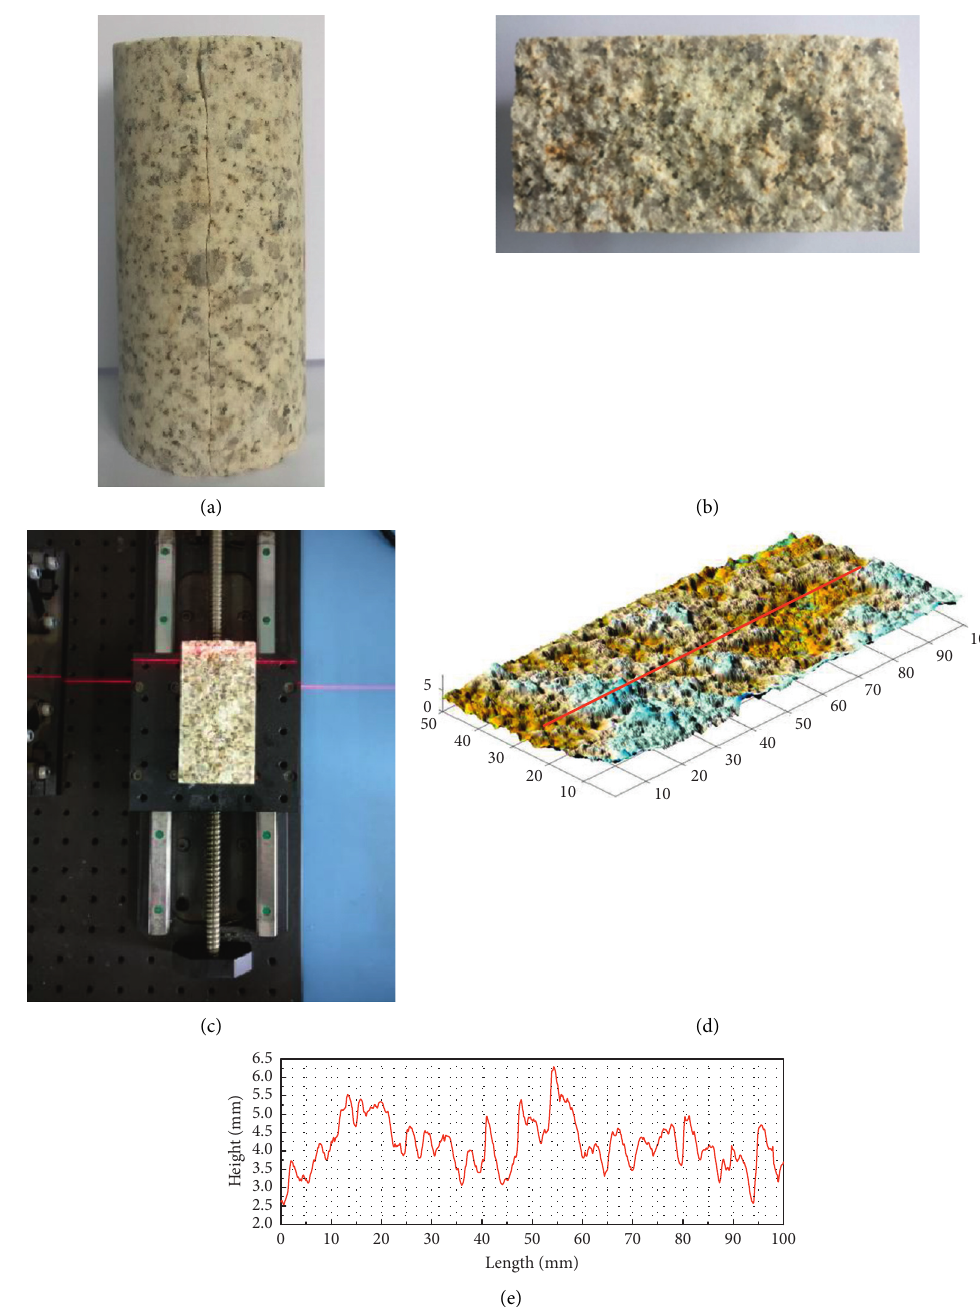
Figure 1: Generating process of the single fracture profile of coarse-grained granite: (a) specimen after Brazilian splitting test; (b) fracture surface formed by splitting; (c) 3D laser scanning; (d) fracture surface generated by scanning; (e) single rough fracture